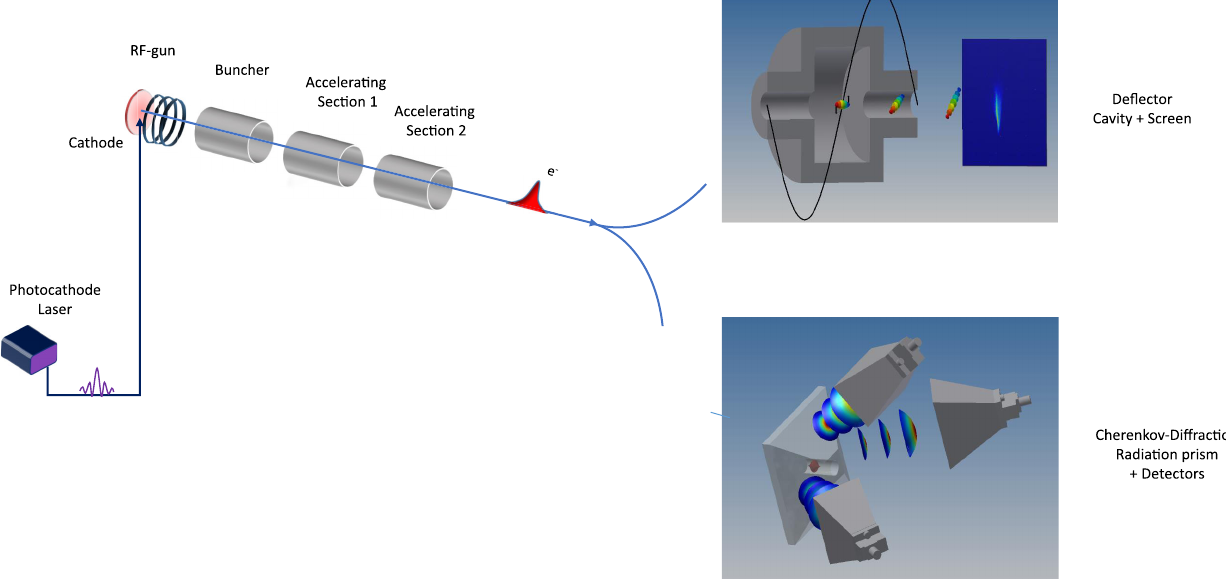
FIG. 7. Sketch of the CLEAR beam line featuring with a rf-deflecting cavity used for longitudinal profile measurement and a dielectric prism made out of PFTE. The CChDR is detected in three independent frequency bands using horns and waveguides. The machine beam parameters are also reported in the